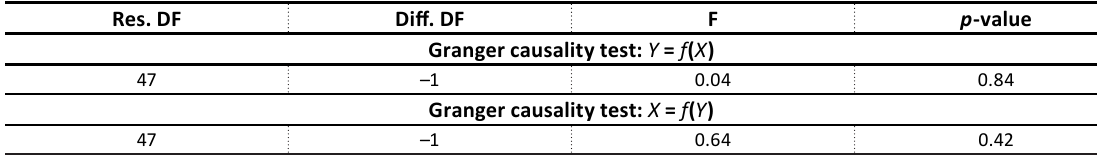
Table E1. Granger causality test: rank ( X ) and PFR ( Y ) Res. DF